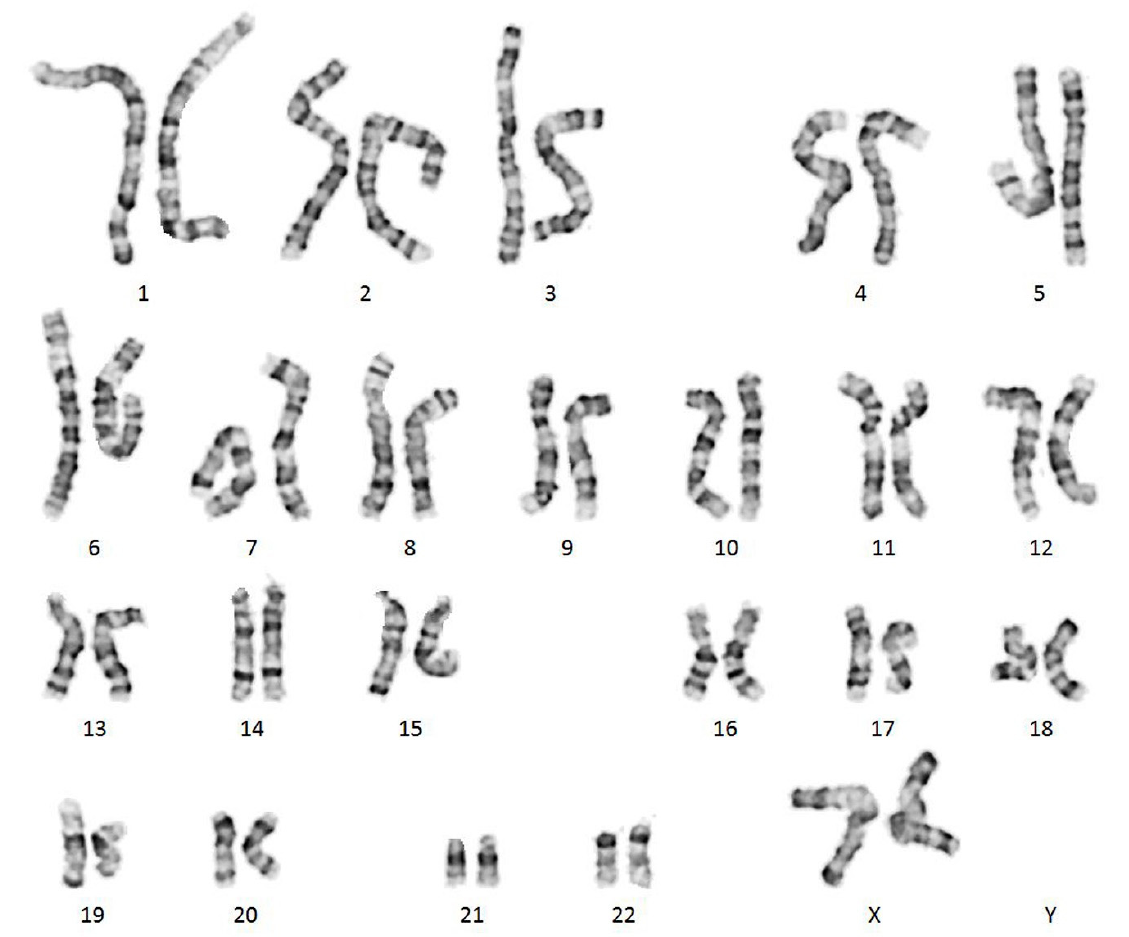
Figure 4. G-banding karyotyping result showing the pictorial alignment of the 22 pairs of homologous autosomes from one metaphase cell, sequentially numbered from chromosome 1 to 22 by their unique band patterns, and the two sex chromosomes, XX (female) or XY (male). The patient has a 46,XX normal female karyotype.